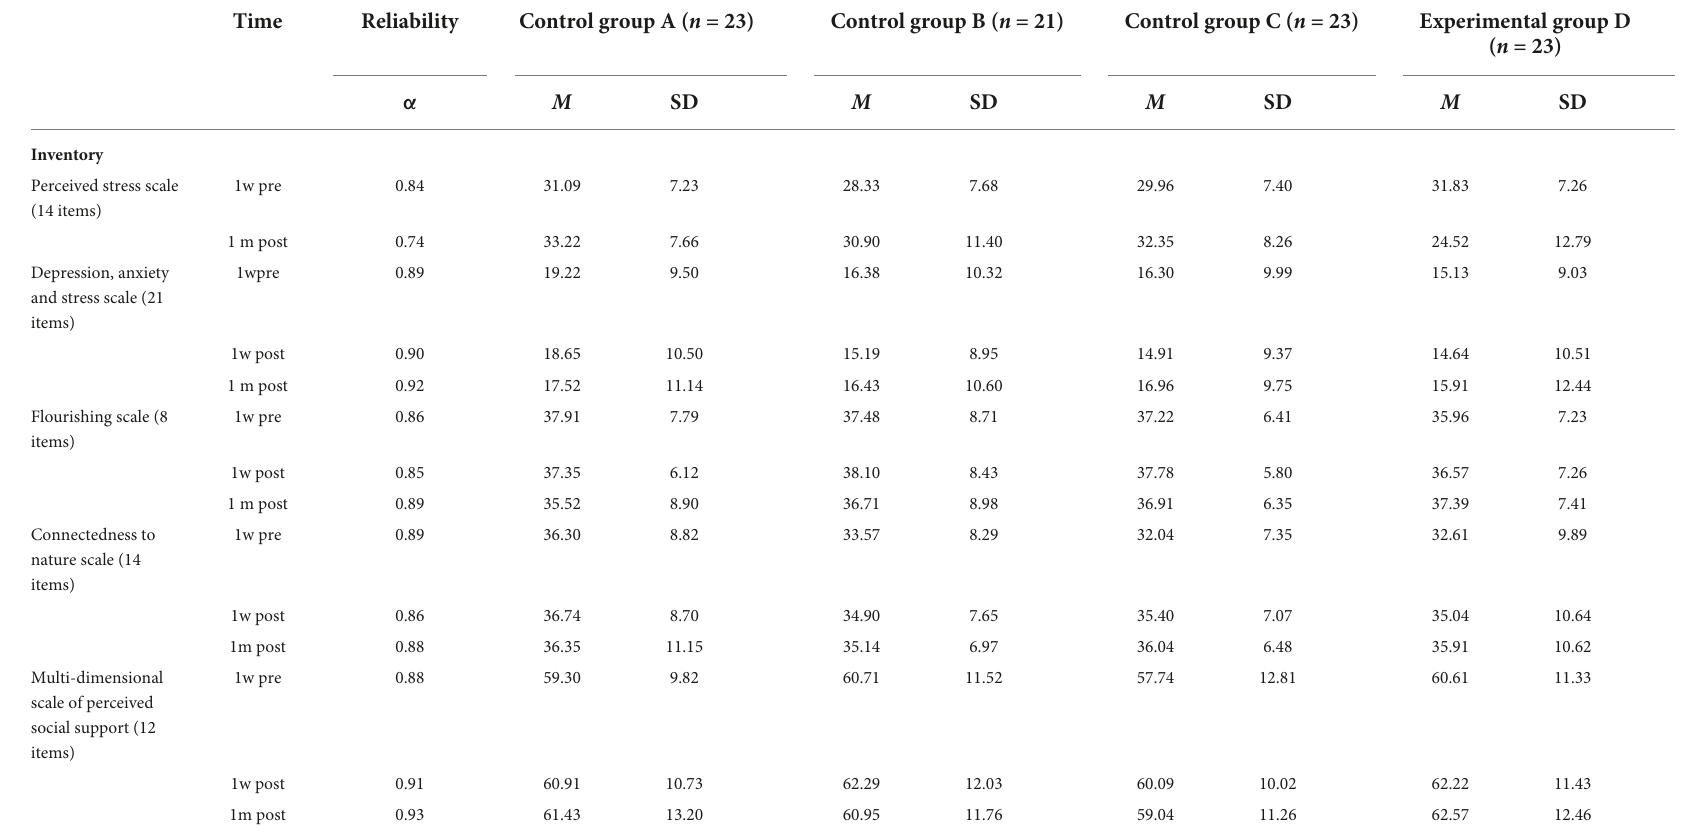
TABLE 1 Mean, standard deviation and reliability of the scales employed in the study ( N =